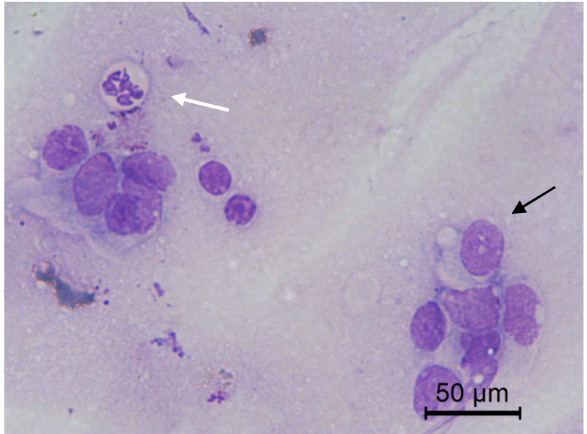
Figure 9. Jenny’s endometrial cytology collected by CB in early diestrus. Cuboidal endometrial cells, vacuolization (black arrow) and neutrophil (white arrow). Dense background present. Modified Wright’s stain 1000 ×